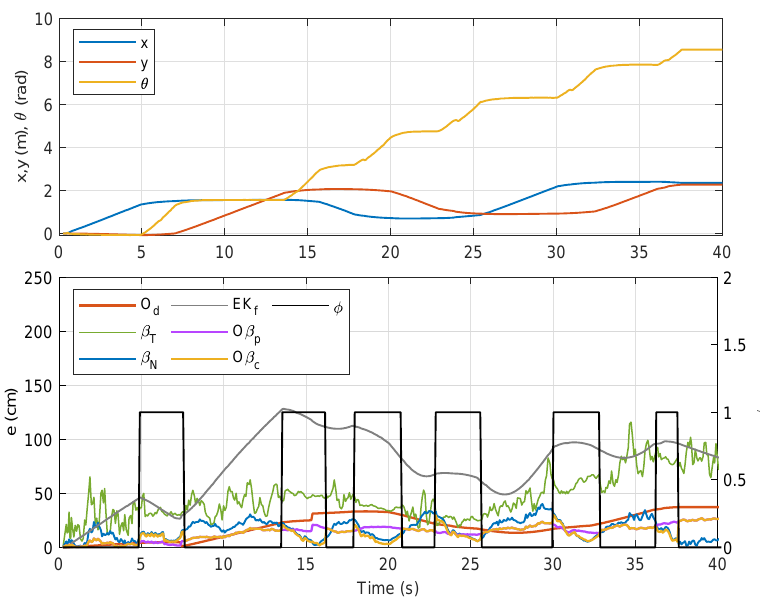
Figure 18. Trajectory 3: Position of NSBot2 in terms of x , y and θ based on odometry ( top ); and temporal localization-error analysis ( bottom